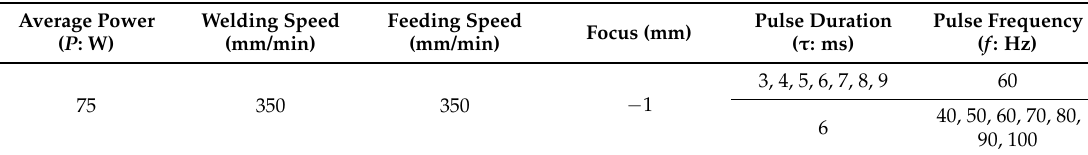
Table 2. Weld parameters.